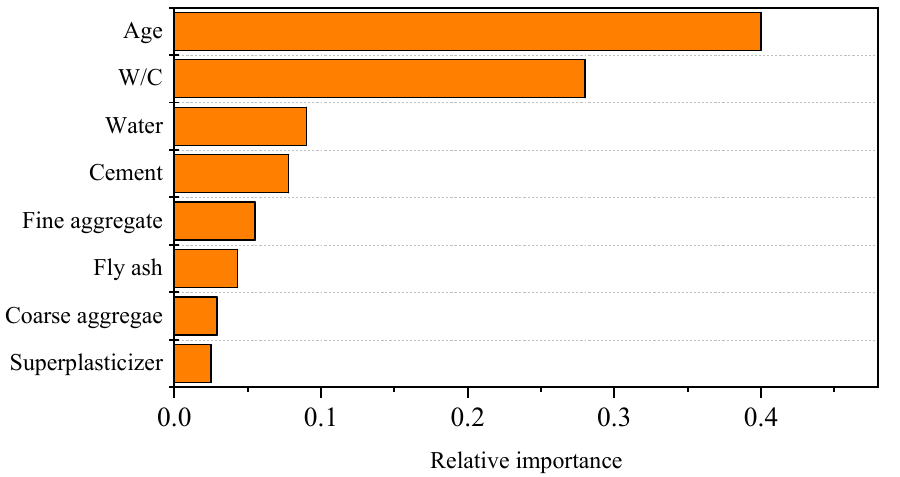
Figure 10. Each variable’s relative contribution to the compressive strength.